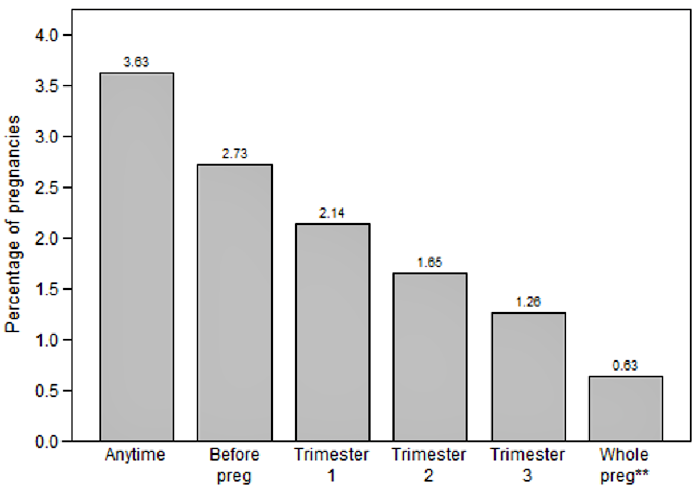
Fig 2. Prevalence of SSRI/SNRI use per 100 pregnancies in the Nordic population by trimester. Preg, pregnancy * at least one dispensed SSRI/SNRI during relevant time window per 100 pregnancies ** whole pregnancy = at least one dispensed SSRI or SNRI during each trimester of pregnancy, including 90 days period before LMP